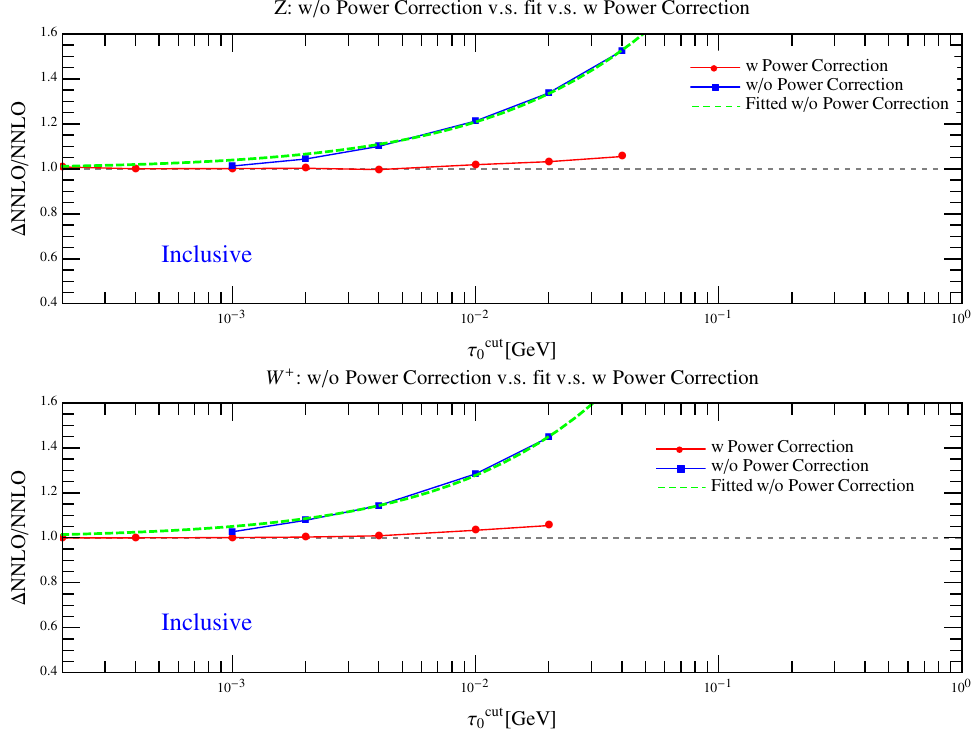
Figure 2 . The di(cid:11)erence between the NNLO coe(cid:14)cients for inclusive Z -boson and W + -boson production at the LHC using N -jettiness subtraction with and without power corrections, normal- ized to the known NNLO coe(cid:14)cient. We have plotted the di(cid:11)erence between the N -jettiness result for the O ( (cid:11) 2 ) correction and the known result, and have normalized this di(cid:11)erence to the known s correction, for this and all other